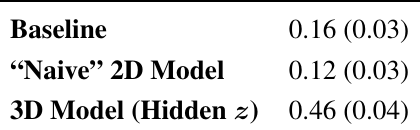
Table 3. Effects of model’s state dimensionality. The average Hamming distance (a number between 0 and 1, with 0 indicating a perfect match) measured over 500 trajectories each of length 1000 (empirical standard errors indicated in parenthesis).